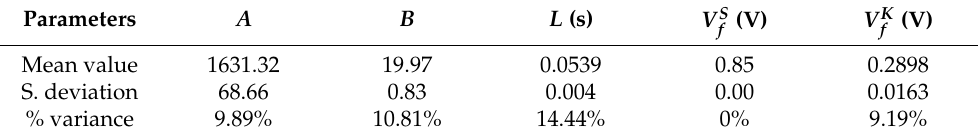
Table 1. Identification results.